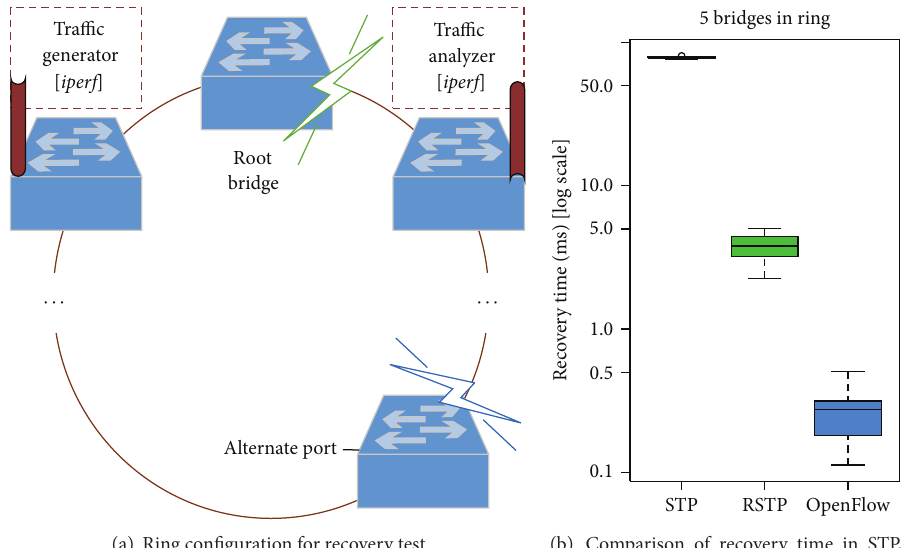
(b) Comparison of recovery time in STP, RSTP, and OpenFlow in a ring of 5 hops Figure 5: Response time test.